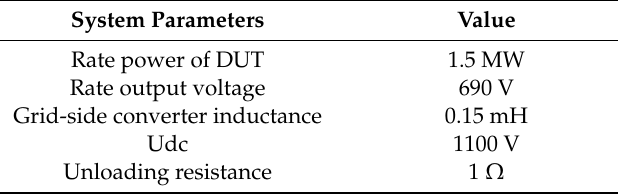
Table 3. Simulation parameters of the wind turbine.